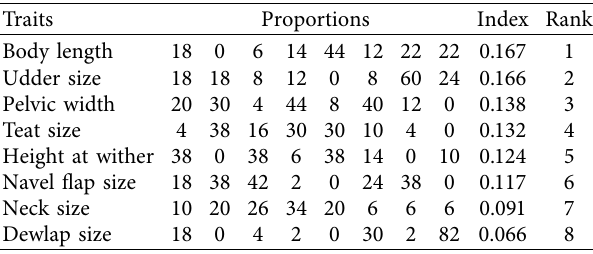
Table 4: Selection criteria of dairy cows in Chora district.